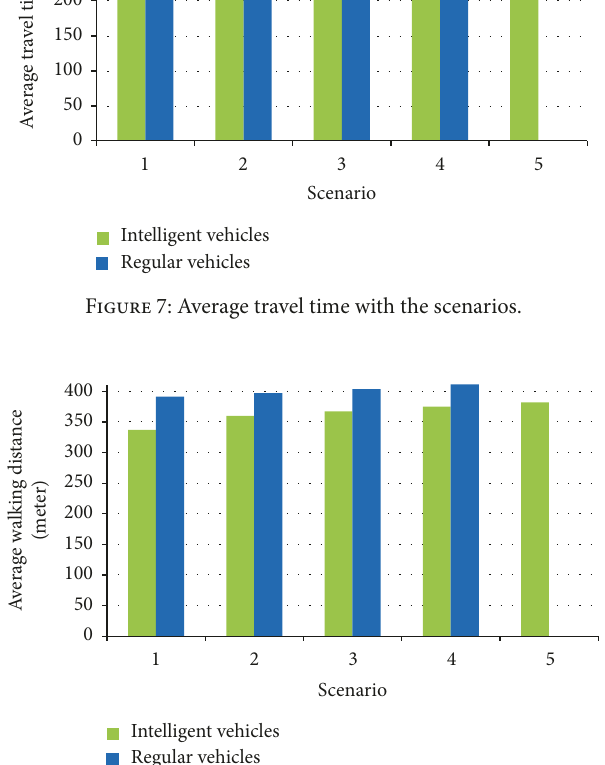
involved components, only the vehicle agents can move